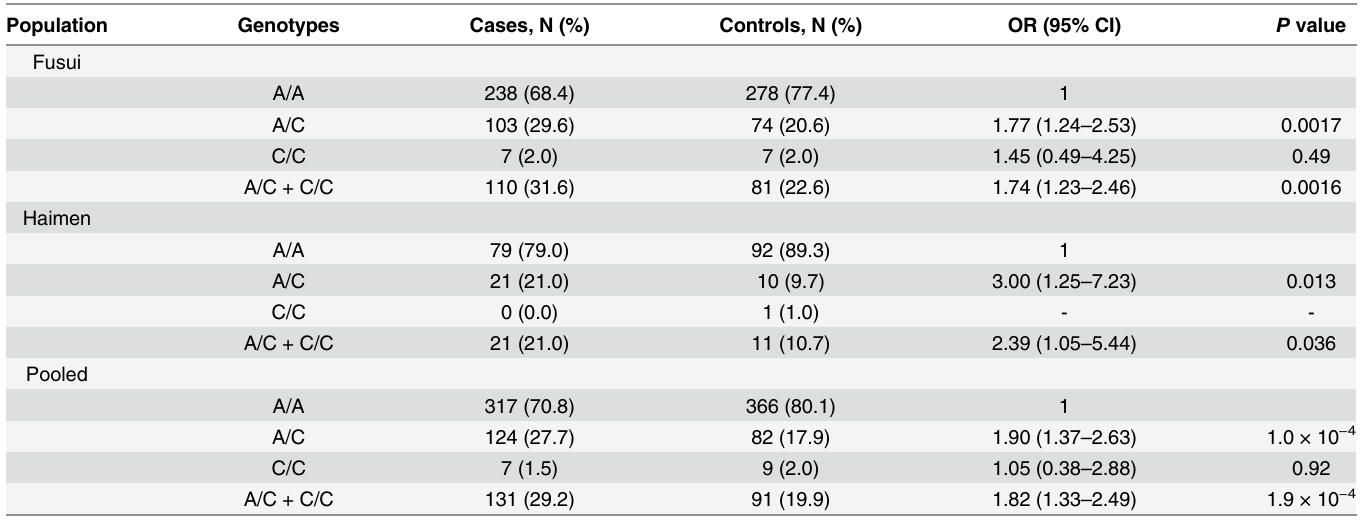
Table 2. Association results of